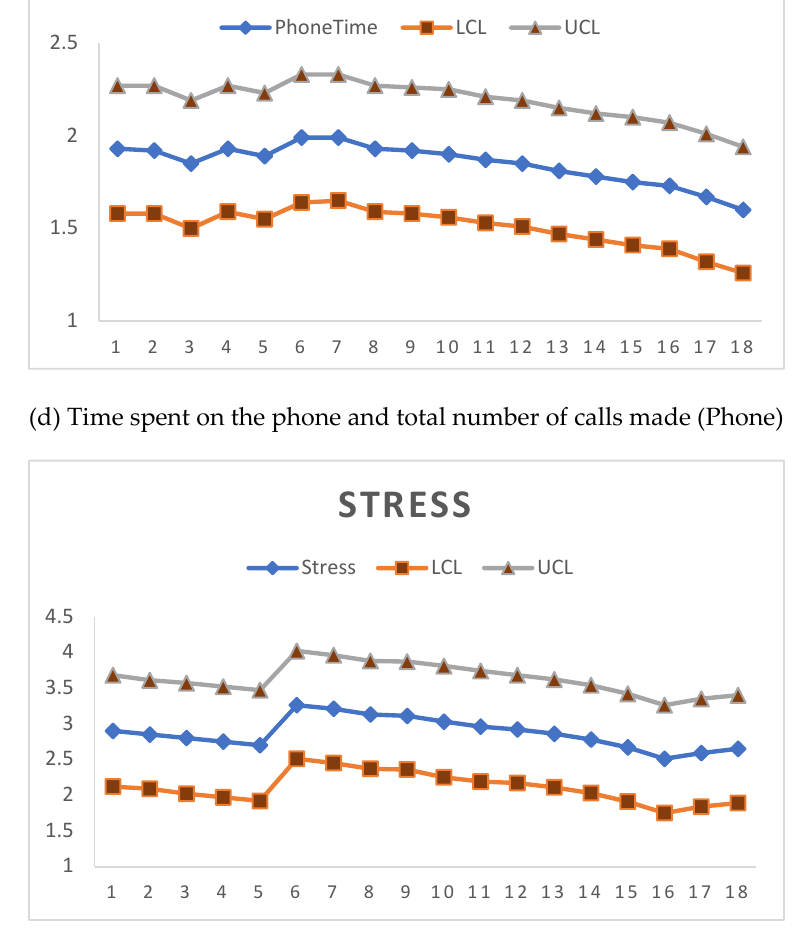
Figure A2. Predicted monthly ratios of objective work performance: ( a ) total number of tasks (Tasks) to total number of hours performed; ( b ) Time and total number of visits; ( c ) Time spent on administrative tasks (Admin) to total number of administrative tasks; ( d ) Time spent on the phone and total number of calls made (Phone); and ( e ) Stress.